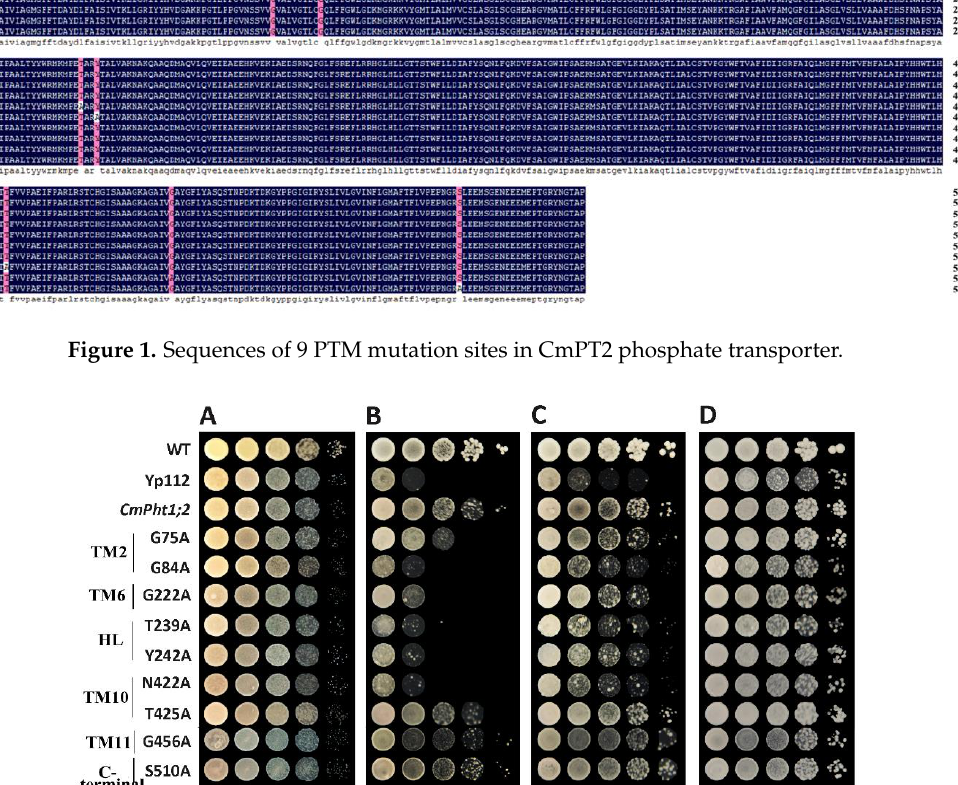
Figure 2. The growth of MB192 expression CmPT2 and Cmphts under different Pi concentrations. ( A ) YPDA medium; ( B – D ) YNB medium supplemented with 20, 60 and 100 μ M Pi, respectively. TM: the